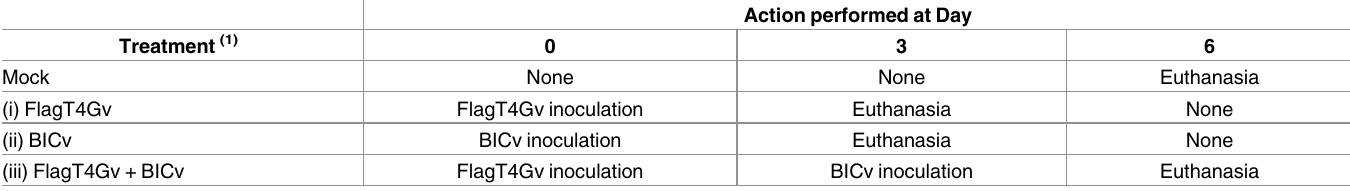
Table 2. Description of the second animal